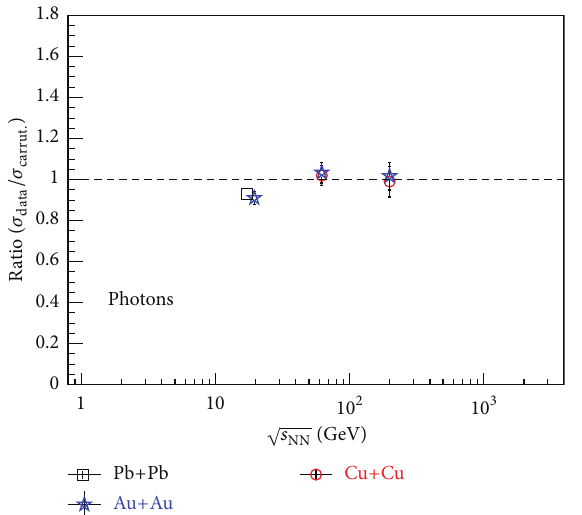
Figure 28: Ratio of the widths of the data and that obtained from the fitting of photon multiplicity distributions of different collision systems as a function of collision energy. Figure 29: Photon multiplicity density normalized per participant